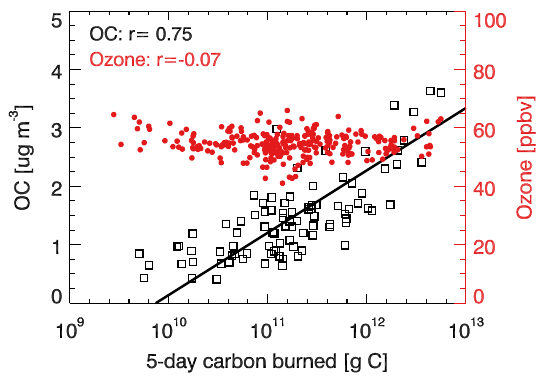
Figure 9. Relationship of organic carbon (OC) aerosol and ozone with wildfire carbon burned in the Intermountain West. Carbon burned is estimated for five-day periods in the summers 2006–2008 over the domain (30–50 ◦ N, 120–100 ◦ W). OC aerosol and ozone concentrations are averages for IMPROVE (OC) and CASTNet (ozone) sites in the domain. The black line represents the reduced- major-axis regression line of OC aerosol concentrations on wildfire carbon